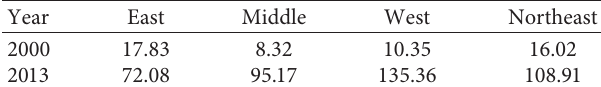
Table 7: Highway mileage per capital in different regions of